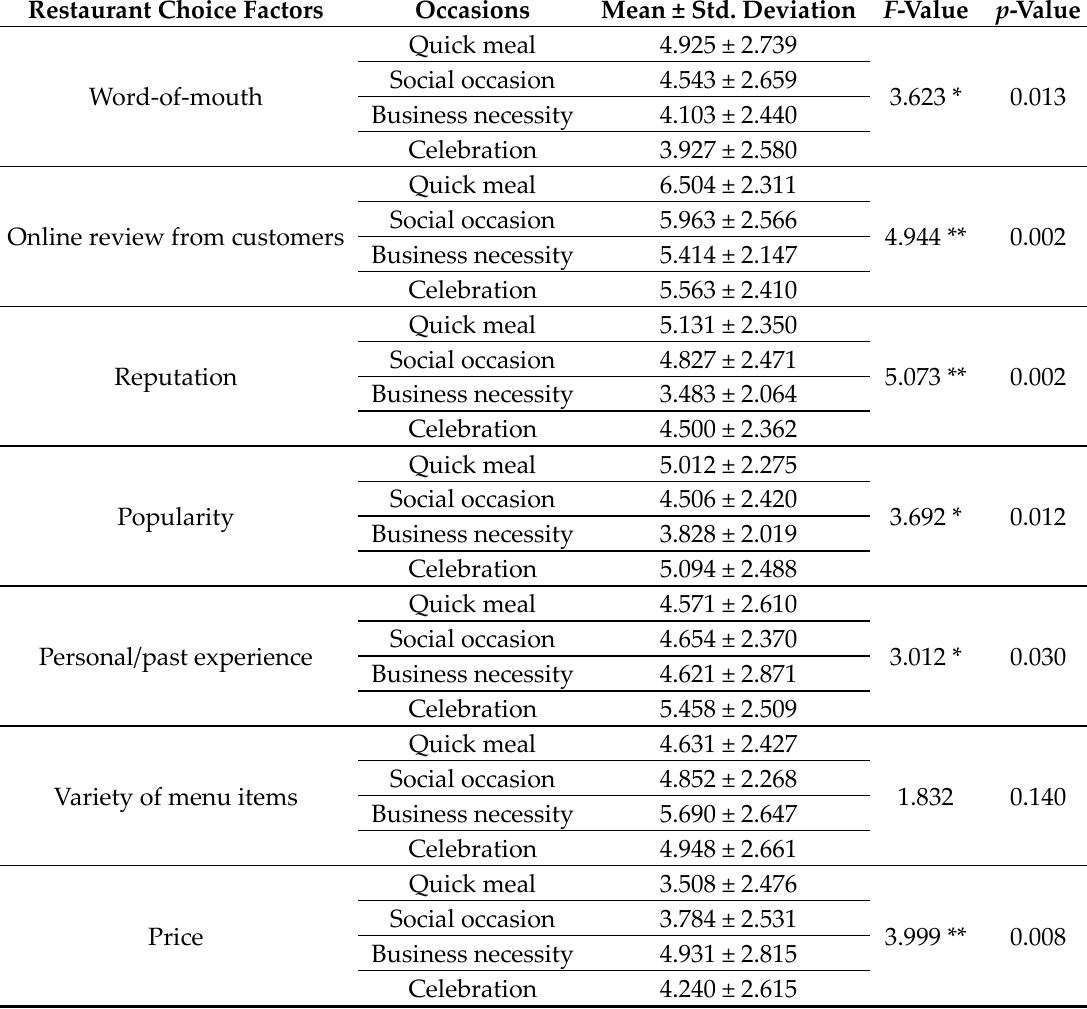
Table 3. Differences in restaurant choice factors across eating-out